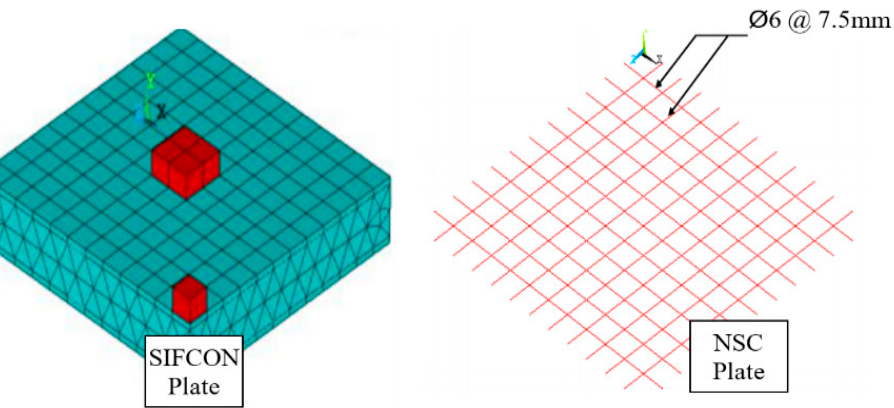
Figure 7. The boundary conditions and finite element idealisation of steel reinforcement of both SIFCON and NSC slab specimens.